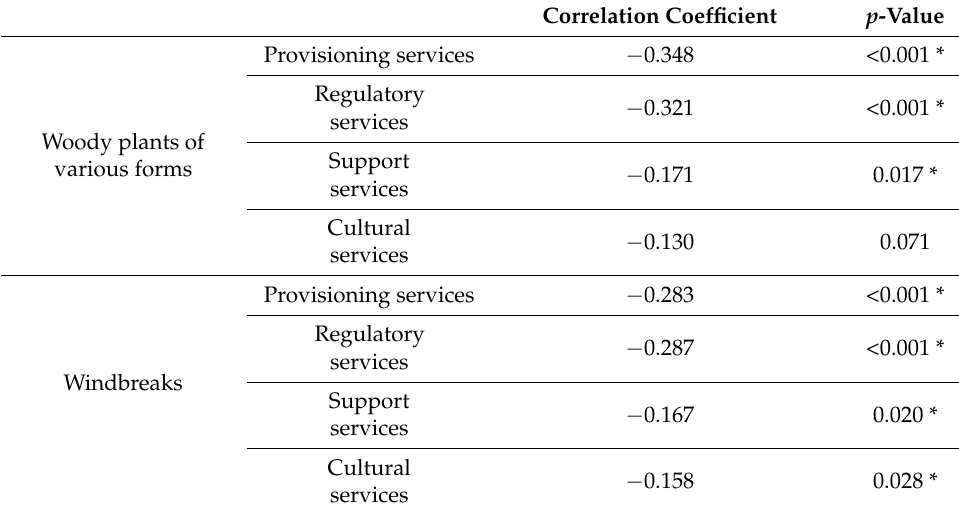
Table 5. Spearman’s correlation coefficient—ES rating by land size.